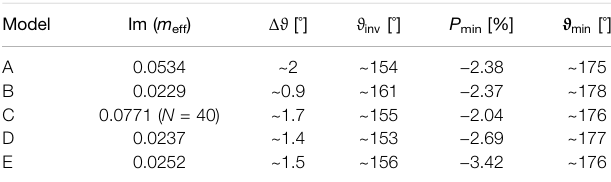
TABLE 1 | The values of Im ( m eff ) in models A − E and the parameters of the phase curves of the normalized intensity and the linear polarization degree for ξ =